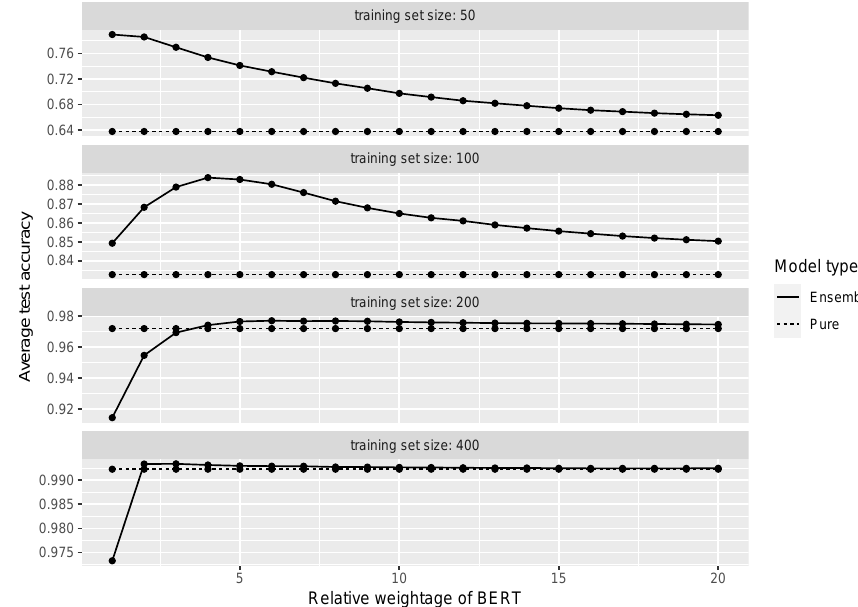
Figure 9. Average test accuracy of BERT and TDA ensembles. The horizontal line is the accuracy of the pure BERT model given as a